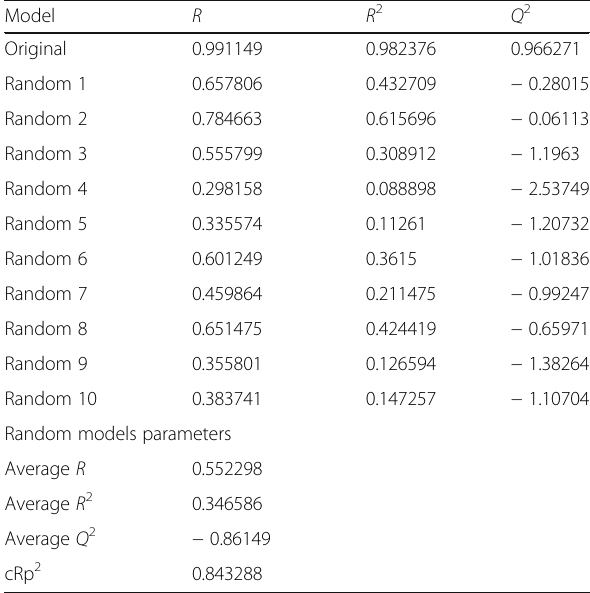
Table 5 Y-randomization result